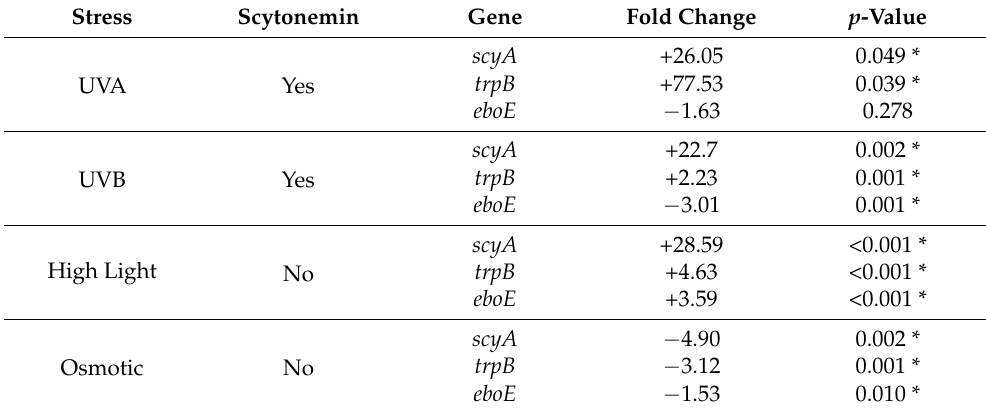
Table 1. Pigment production and transcript abundance of scyA, trpB , and eboE following 48 h of stress. Stress Scytonemin